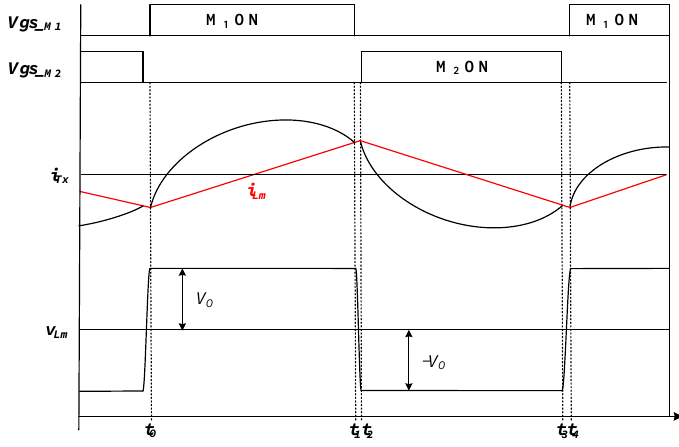
Figure 7. Operational waveform in LLC resonance operation.